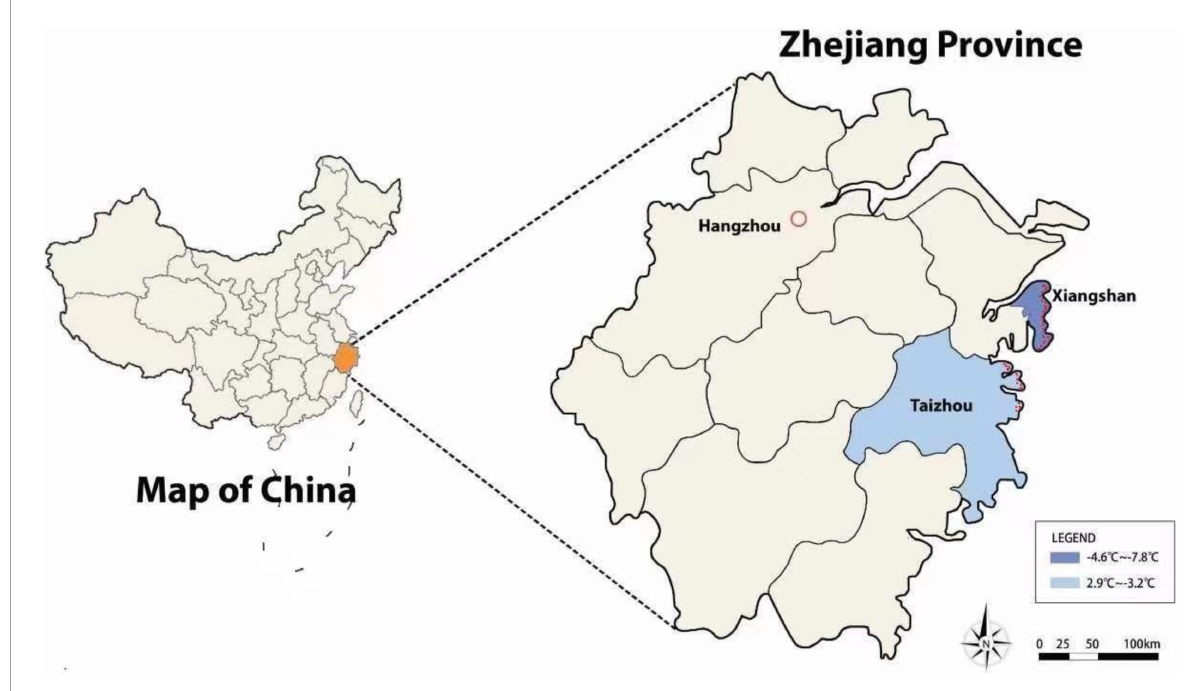
FIGURE1 Minimum air temperatures of the experimental zones from 20–28 January of 2016. The red points along the coastline represent specific sampling